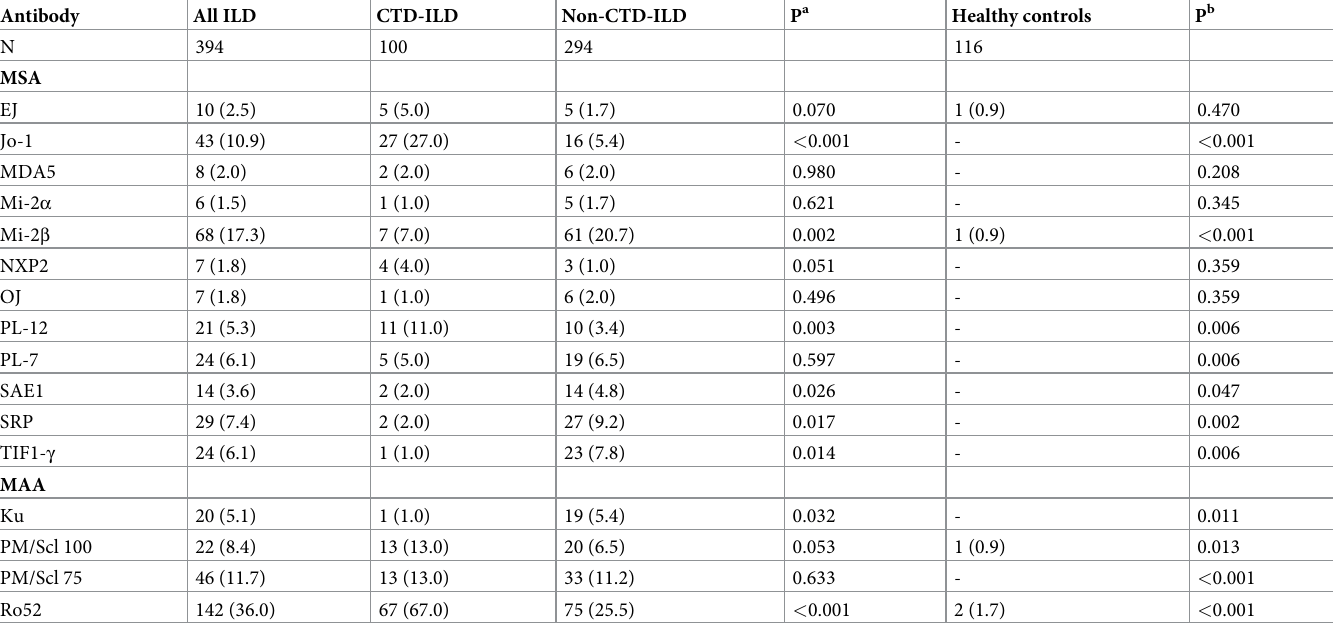
Table 2. Frequency of myositis antibodies in ILD patients and healthy